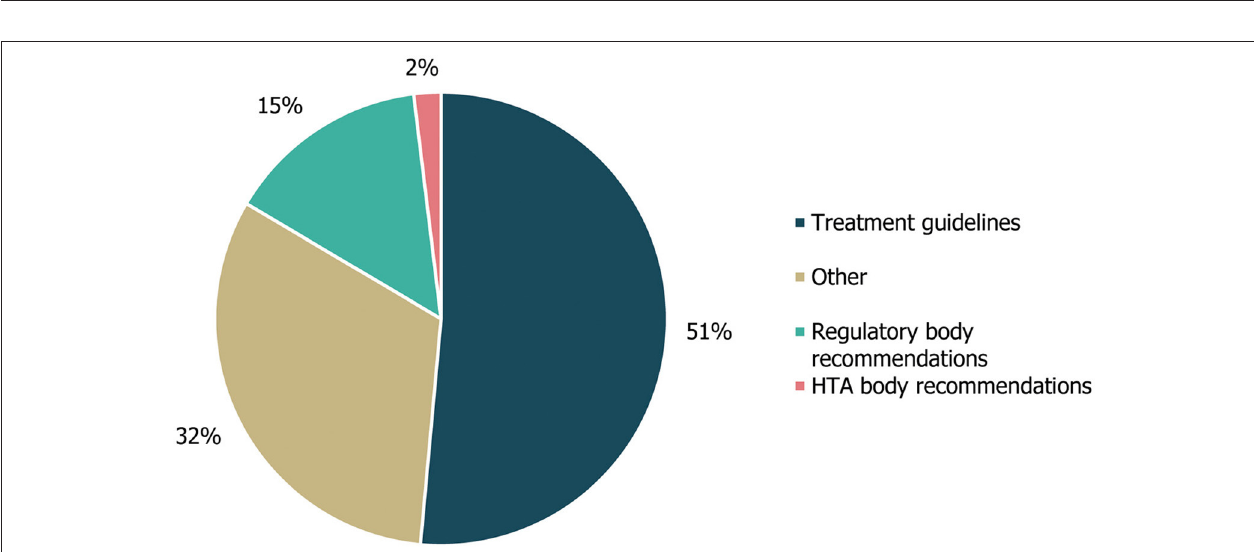
FIGURE 4 | Types of expert consultation performed to inform guideline development. “None” refers to guidelines in which expert consultation was explicitly not used; NR, not reported. *Other refers to working groups or targeted expert interviews.